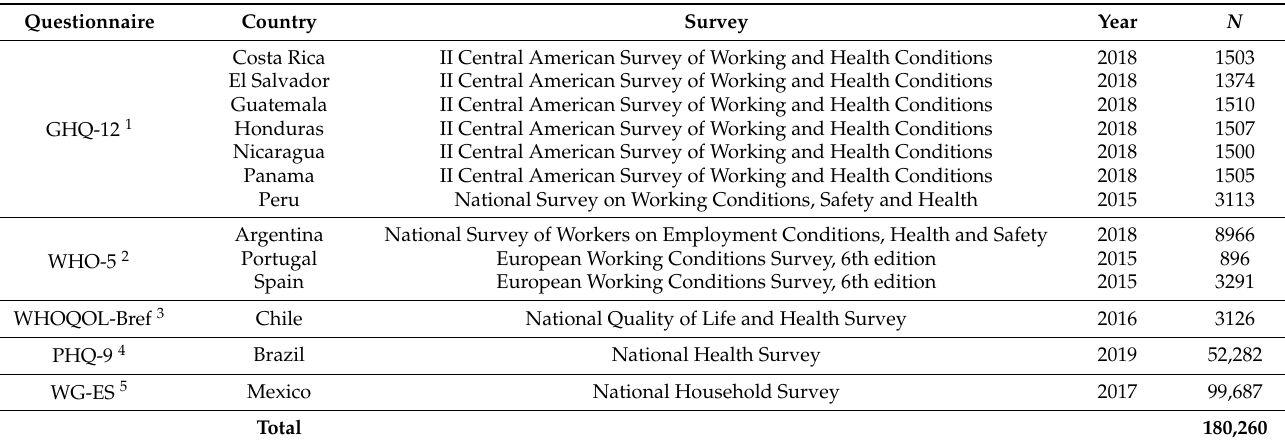
Table 1. Data source and mental health measurement